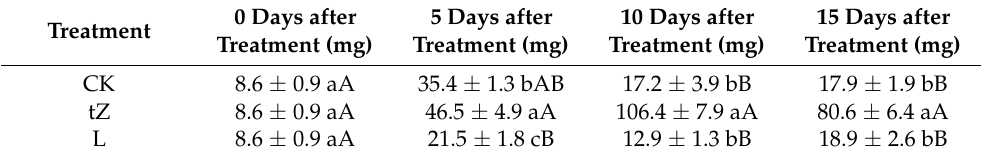
Table 1. The weight of per aborted small seeds.